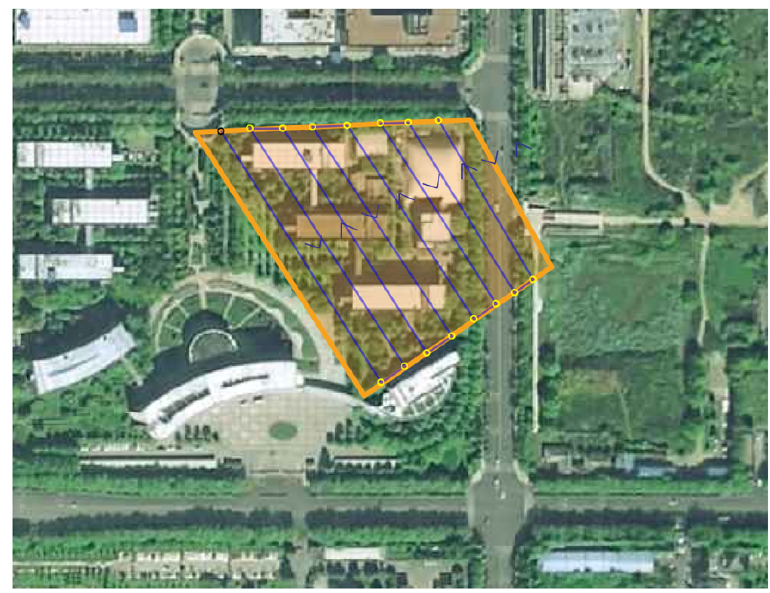
Figure 6. The UAV flight